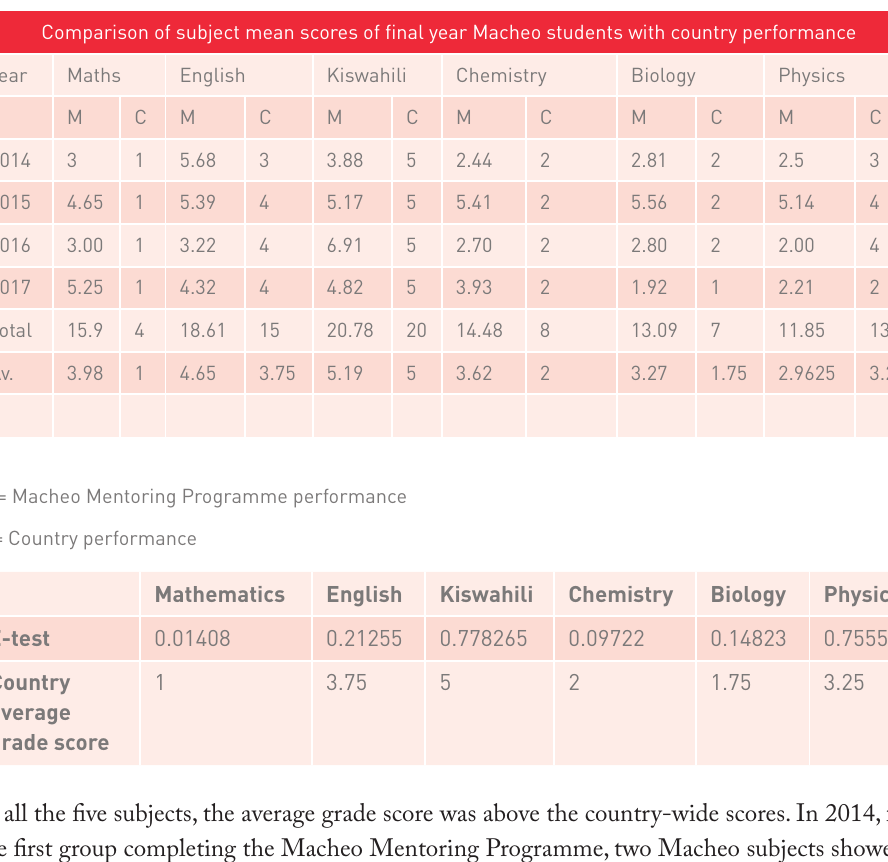
Comparison of final year